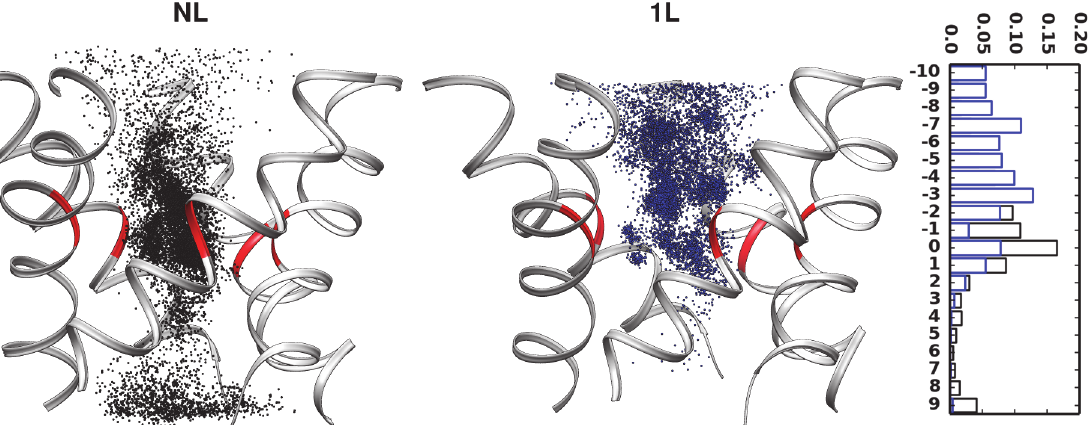
Fig 4. Ion occupancy and histogram of ion counts along the axial positions. Occupancy of K + ion inside the pore obtained by extracting the ions within a distance of 10 Ang from the mutated site along the radial and axial dimensions. Right panel shows the histogram of K + counts along the axial positions for NL (black) and 1L (blue)